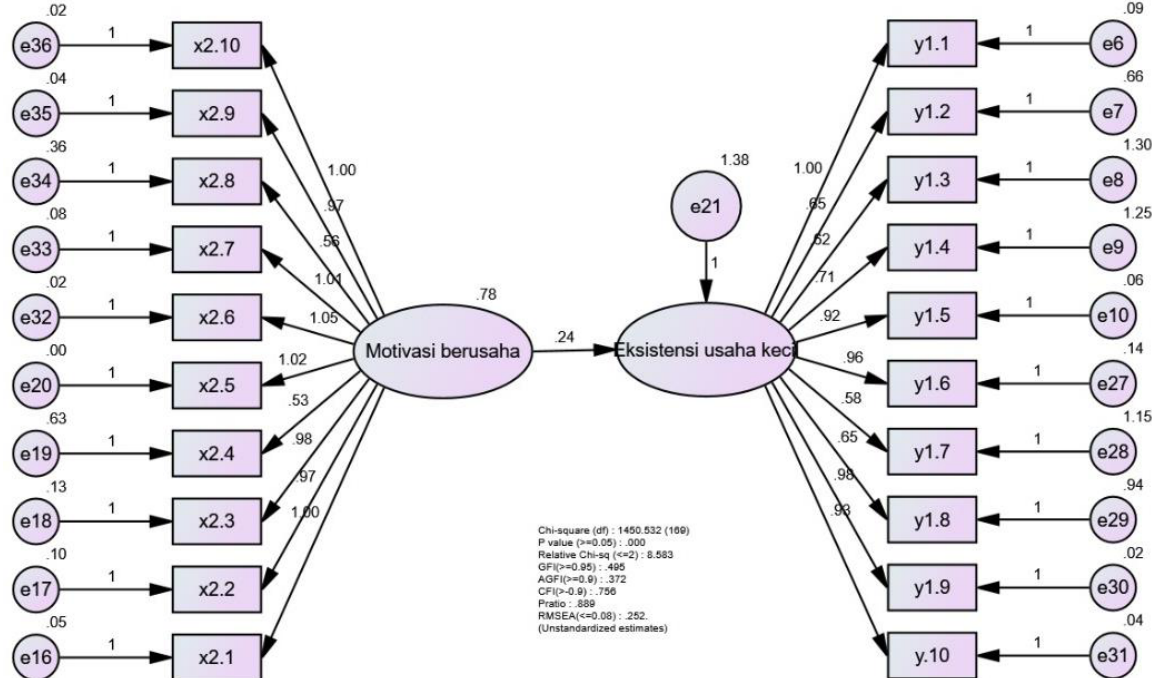
Figure 3. Exogenous Construct Model of Business Motivation Variable on Business